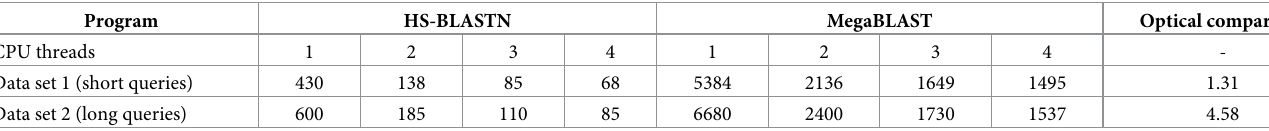
Table 11. Runtime (second) taken to search long and short query sequence in human